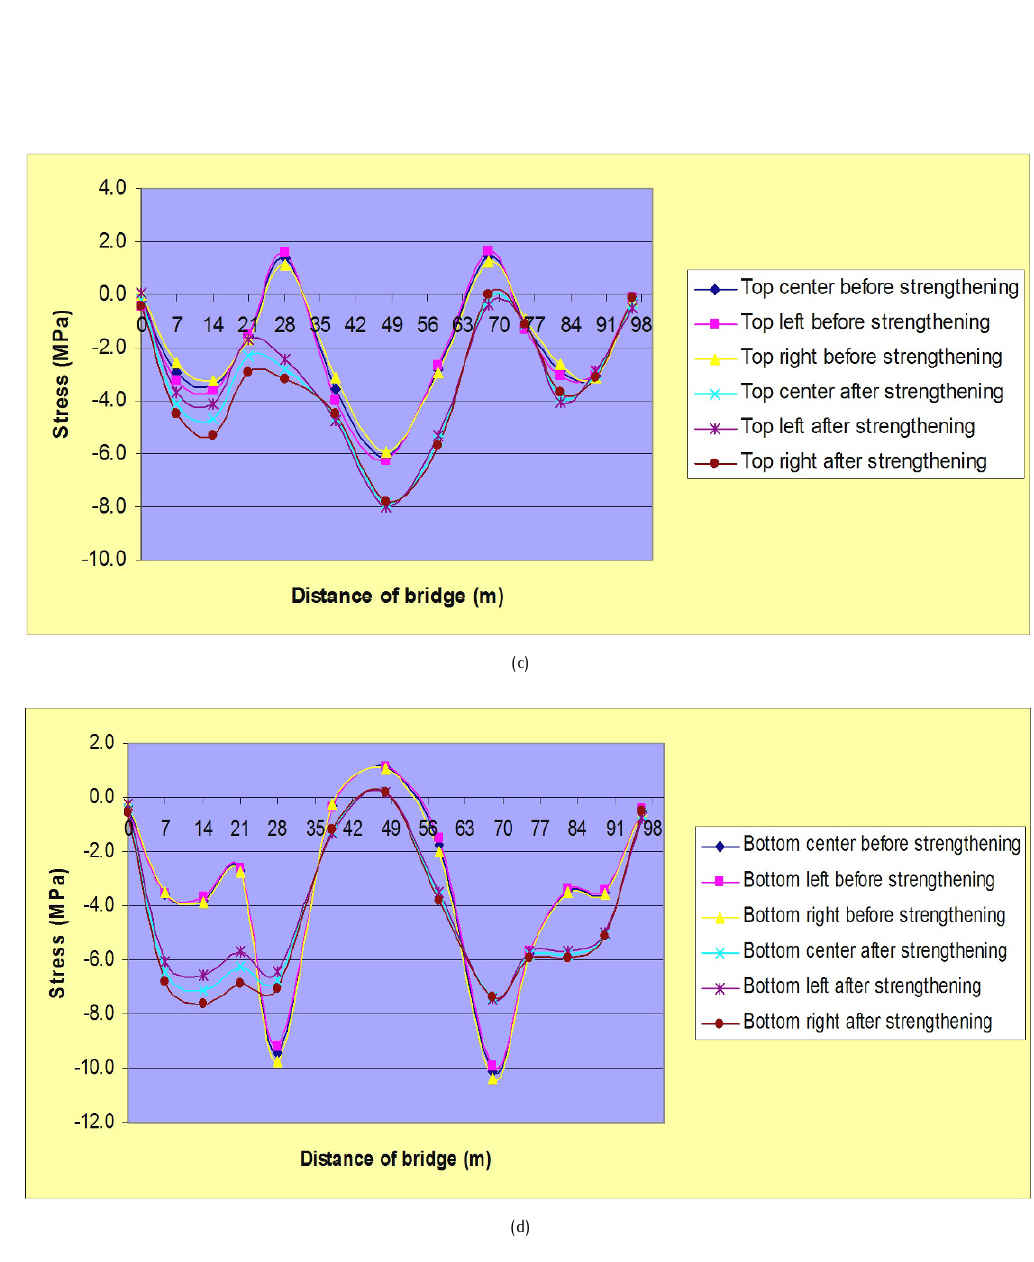
Figure 14. (continued) The values of stresses before and after strengthening due to load combination II for object No.2, (c) Min. top value of box girder, (d) Min. bottom value of box